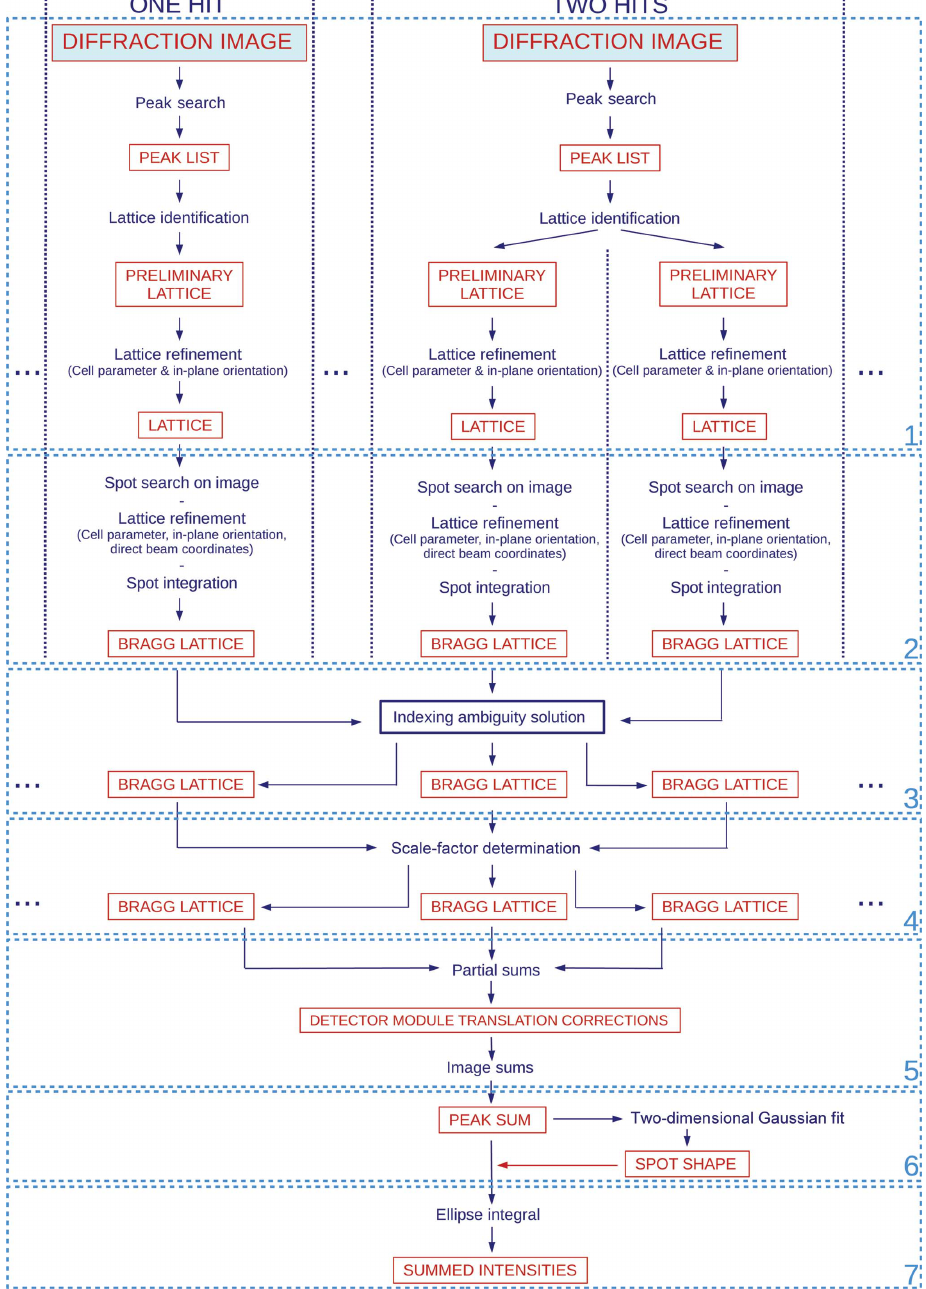
Figure 2 Data-analysis protocol. The flowchart shows an overview of the applied data-analysis protocol. The various steps are described in x 2.3. The columns with dotted-line borders correspond to one diffraction image, from which one or more lattices are